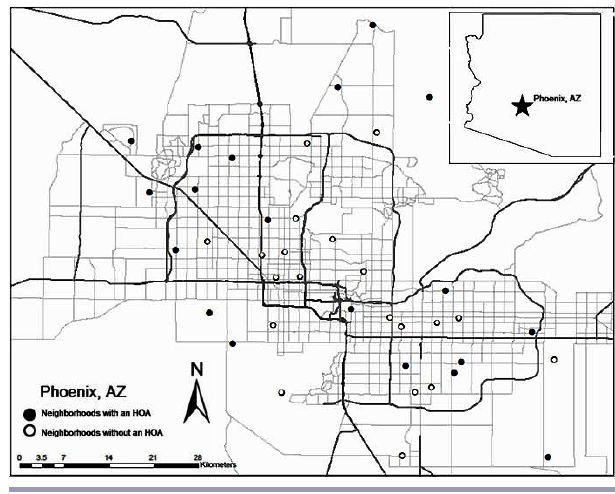
Fig. 1. Map of study area, including locations of neighborhoods surveyed for bird, plant, and arthropod diversity in Phoenix, Arizona. Shaded circles indicate HOA